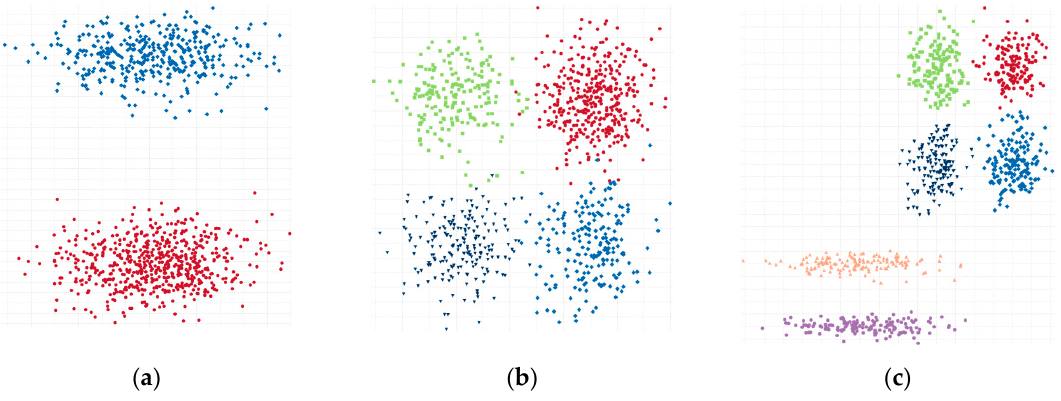
Figure 1. ( a ) Synthetic dataset Long2; ( b ) synthetic dataset Sizes1; ( c ) synthetic dataset